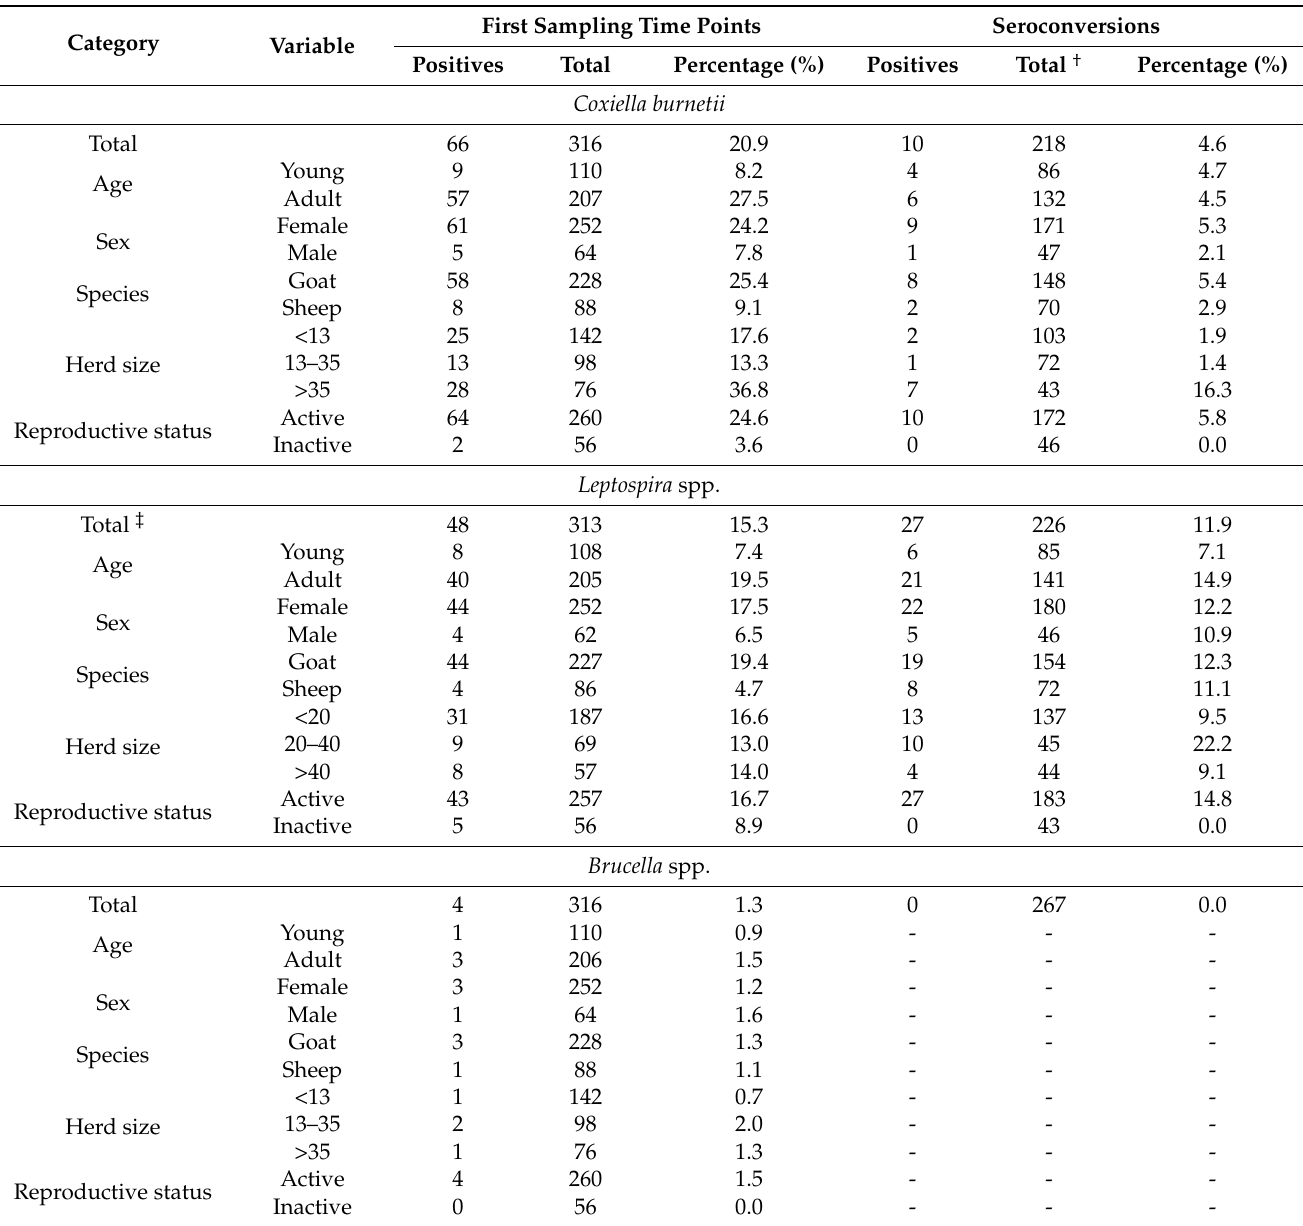
Table 2. The distribution of animals seropositive for C. burnetii , Leptospira , and Brucella with animal and household characteristics. The study period was between September 2014 and June